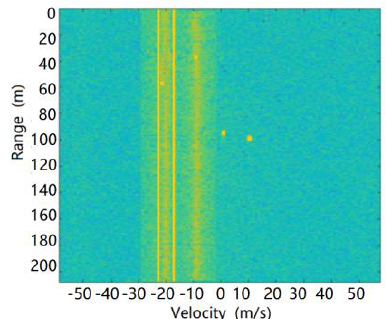
Figure 23. RD spectrum of radar echoes in highway scene with heavy rain.